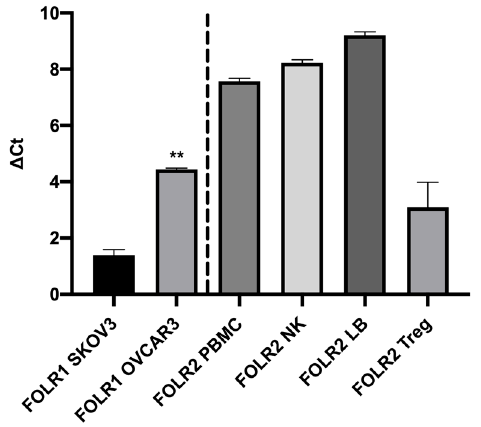
Figure 1. RT-QPCR analysis of FOLR1 and FOLR2 gene expression by ovarian tumor cells and immune cells. FOLR1: Folate Receptor 1, FOLR2: Folate Receptor 2, PBMC: Peripheral blood mononuclear cells, NK: Natural Killer; LB: Lymphocyte B, Treg: Regulatory T Lymphocyte. Δ Ct = Ct target gene −